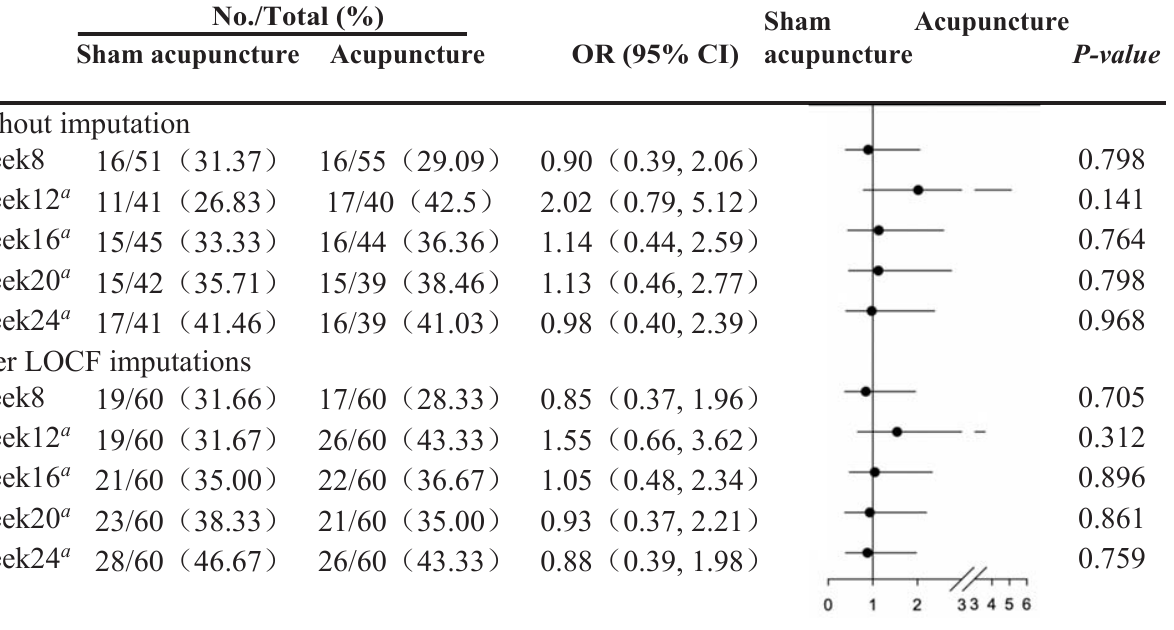
TABLE 3 | Number (proportion) of patients reaching the primary outcome at different weeks.